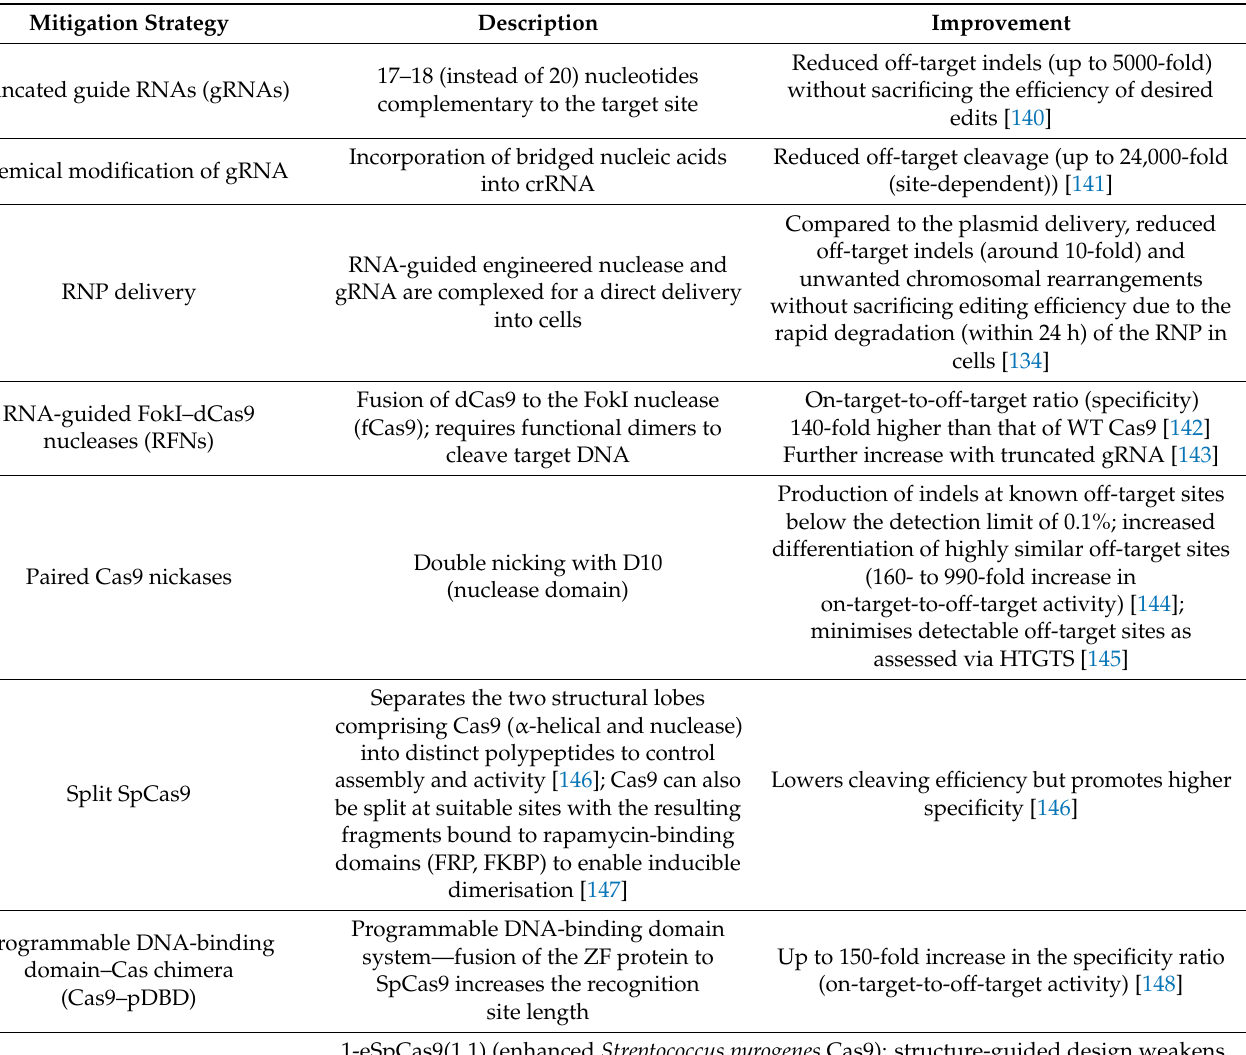
Table 8. Mitigation strategies and potential improvements for off-target activity in CRISPR-Cas (adapted from [86], which offers an excellent review on these